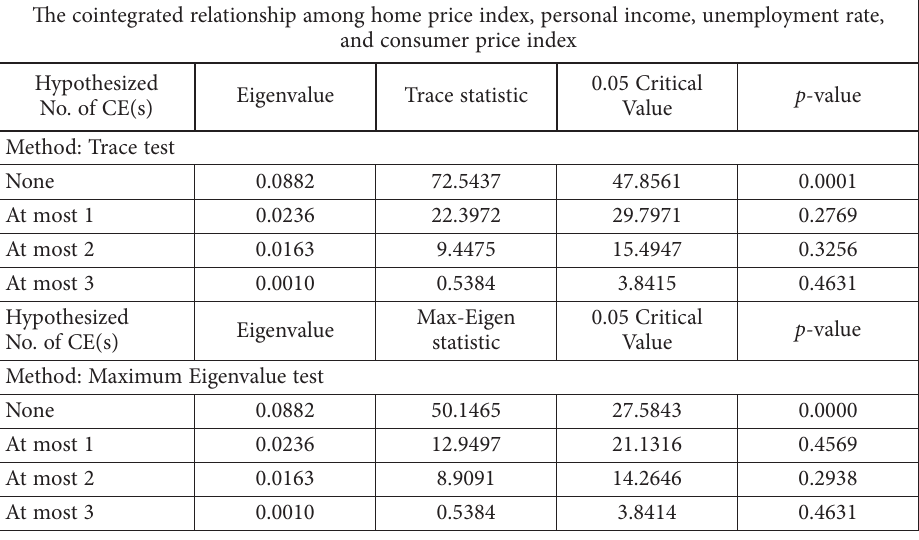
Table 2. Unrestricted cointegration rank